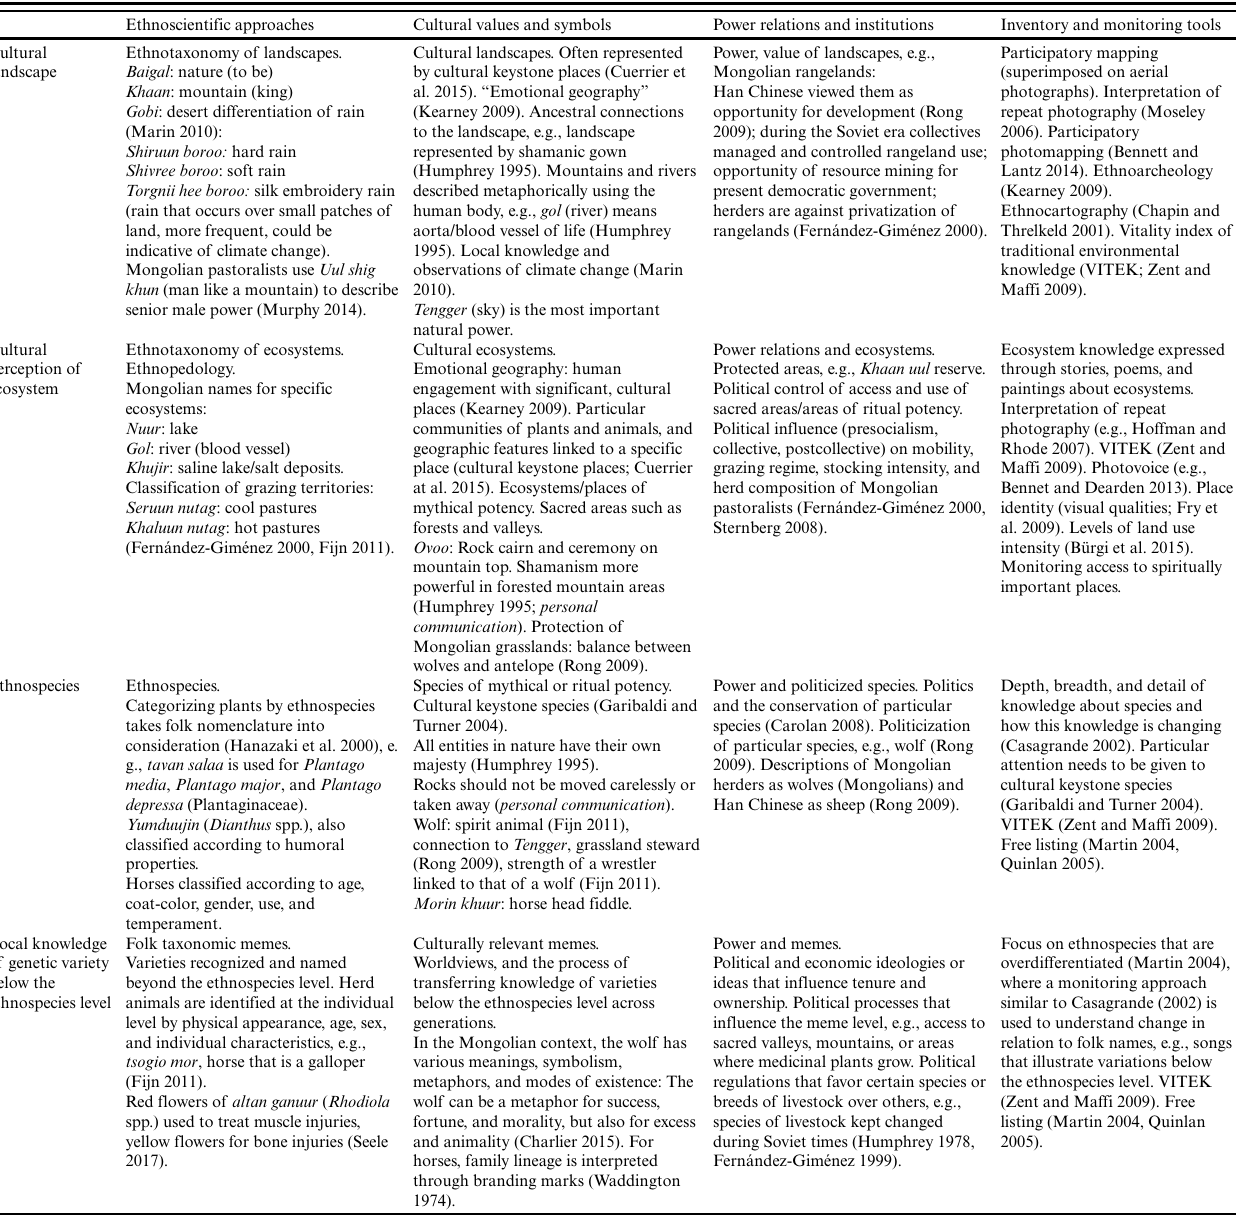
Table 2 . Examples of cultural factors that influence biocultural diversity in the Mongolian pastoralist context, using ethnoscientific approaches, cultural values and symbols, and power relations and institutions along four levels of organization. Adapted from Noss